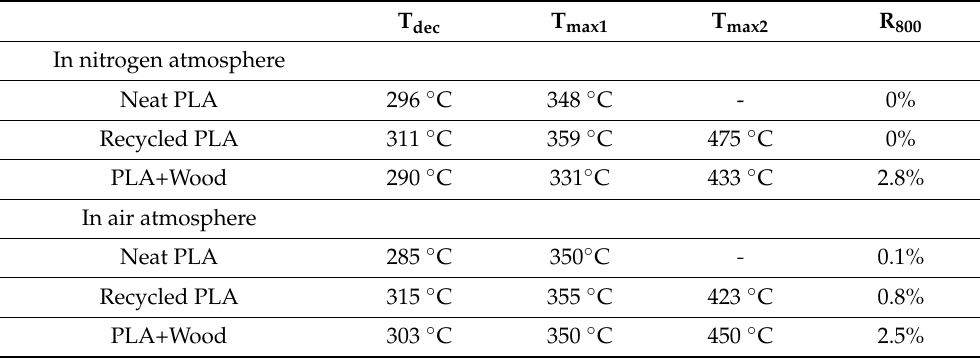
Table 3. Initial decomposition temperature (T dec ), temperature corresponding to the maximum rate of decomposition in the first step (T max1 ), temperature corresponding to the maximum rate of decomposition in the second step (T max2 ), remaining mass % of material at highest testing temperature (R800). T dec T max1